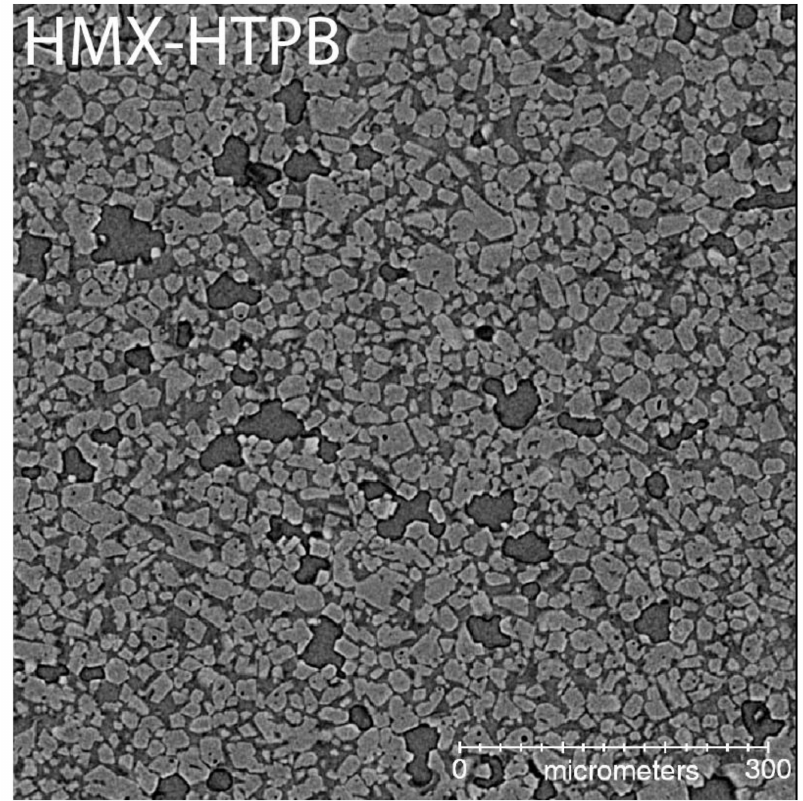
Figure 1. HMX-HTPB formulation imaged with high resolution X-ray microcomputed tomography ( µ CT). The crystals are the light gray, the binder is a medium gray, and the voids are the darkest gray. Some phase contrast (light–dark halo) is seen around the voids. This is minimized by reducing the distance from the sample to the detector